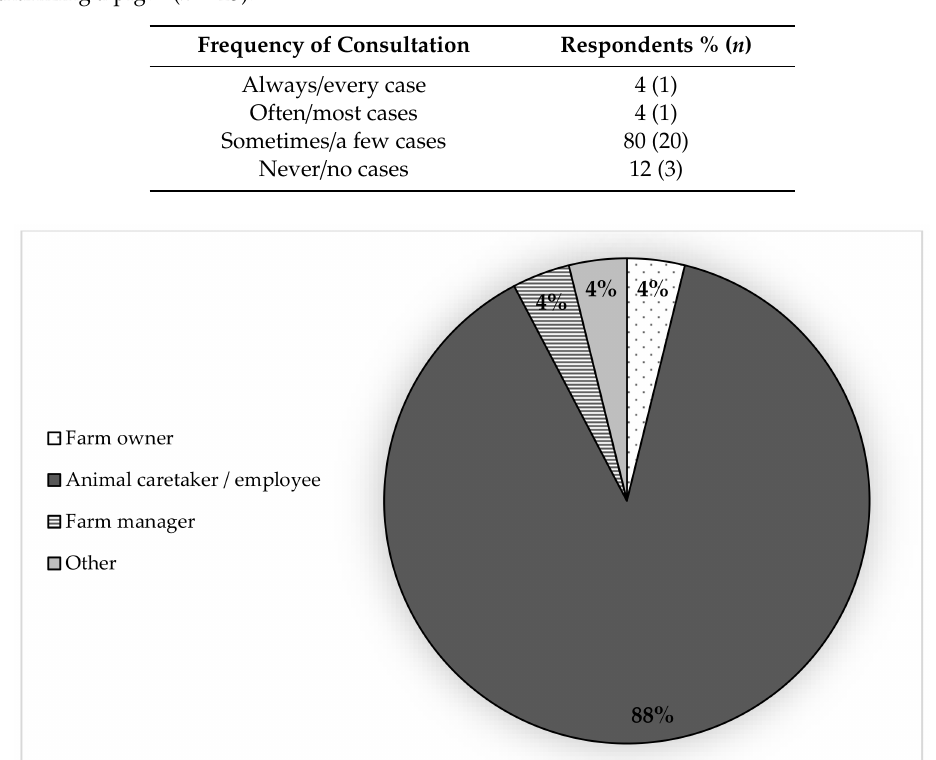
Figure 2. Respondents were asked “If someone else performs most of the euthanasias, what is this person’s role?” ( n = 25). The options provided for selection were: farm owner, farm manager, animal caretaker / employee, other, or decline to